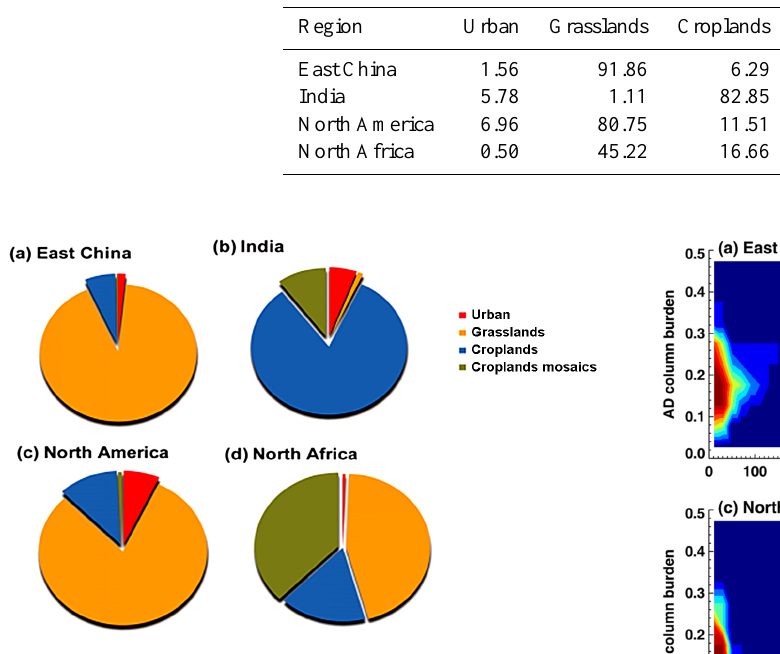
Figure 12. Percentage of different types of land cover in semi-arid regions of East China (a) , India (b) , North America (c) , and North Africa (d) .